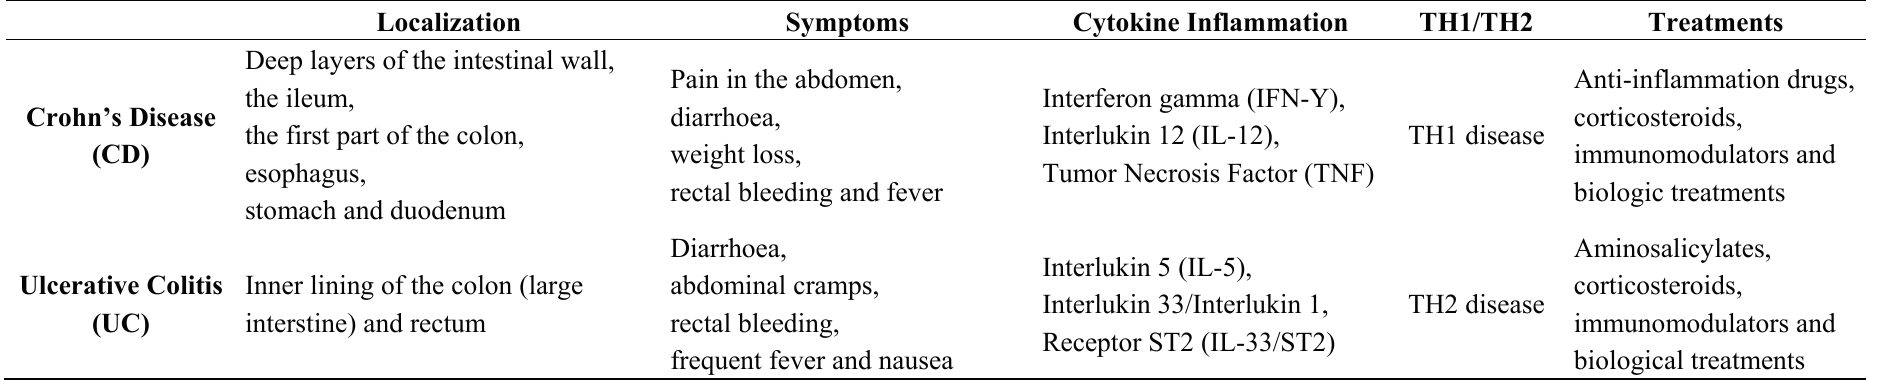
Table 2. Characteristics of inflammatory bowel disease.